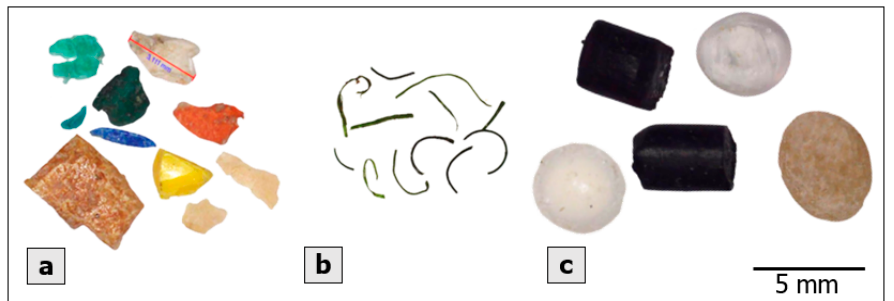
Figure 5. Typical microplastics of different shapes of this study: fragment ( a ), fiber ( b ), granule ( c ).